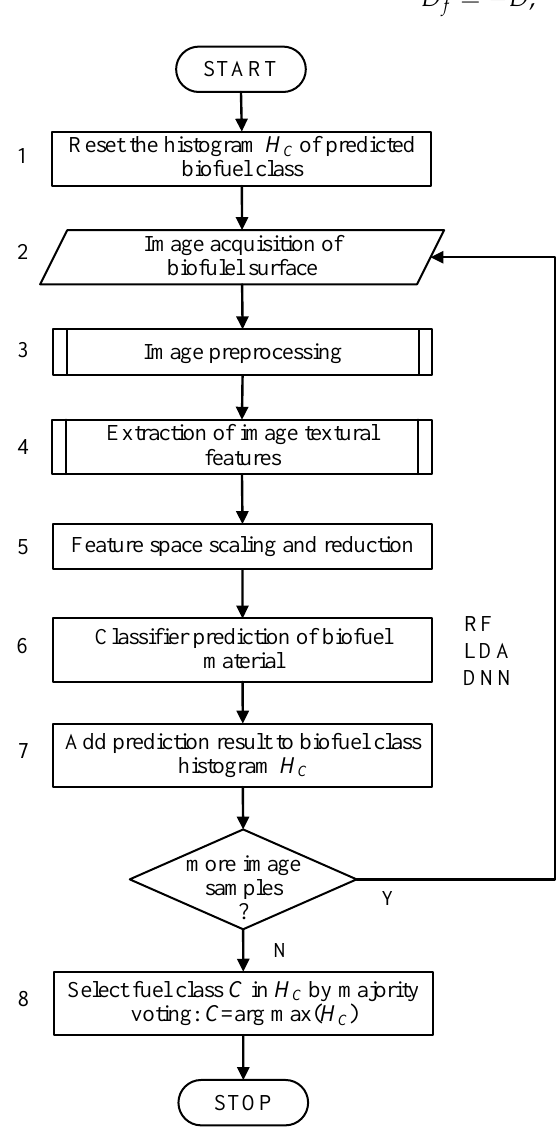
Figure 5. Flowchart of the algorithm in prediction mode: RF —random forest classifier; LDA —linear discrimination analysis; DNN —deep neural